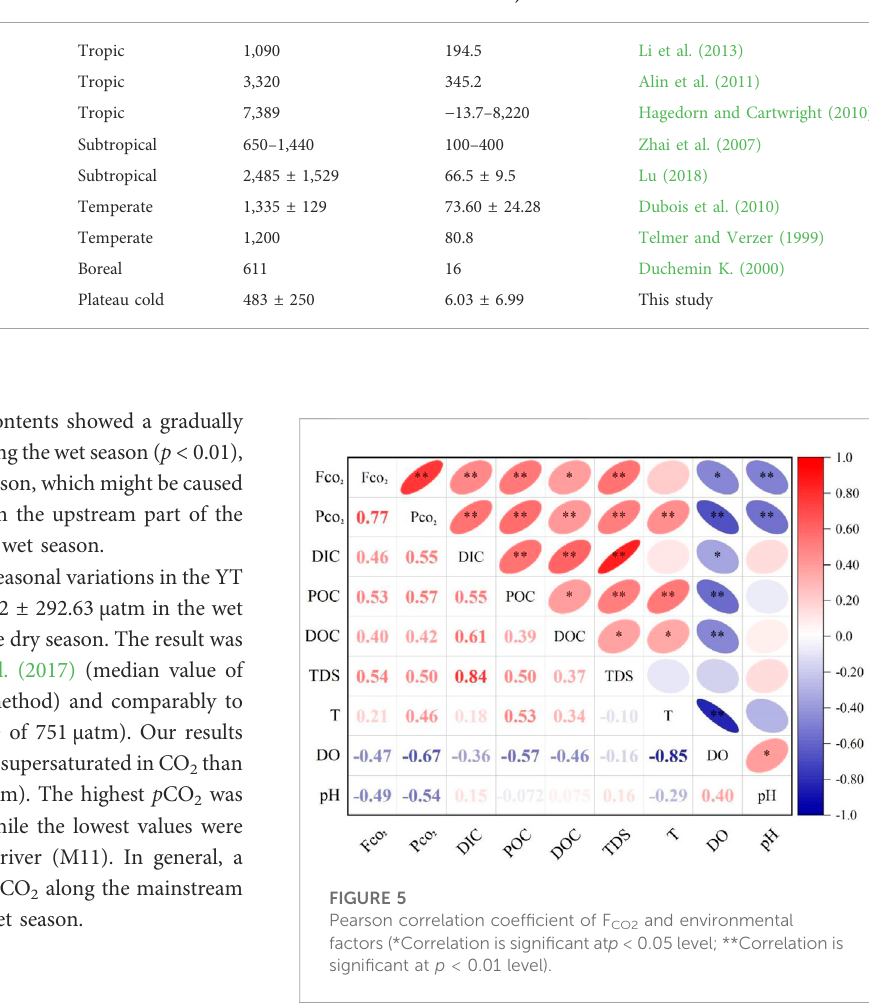
TABLE 2 A comparison of the CO 2 ef fl uxes produced by large rivers across the globe. River/Basin